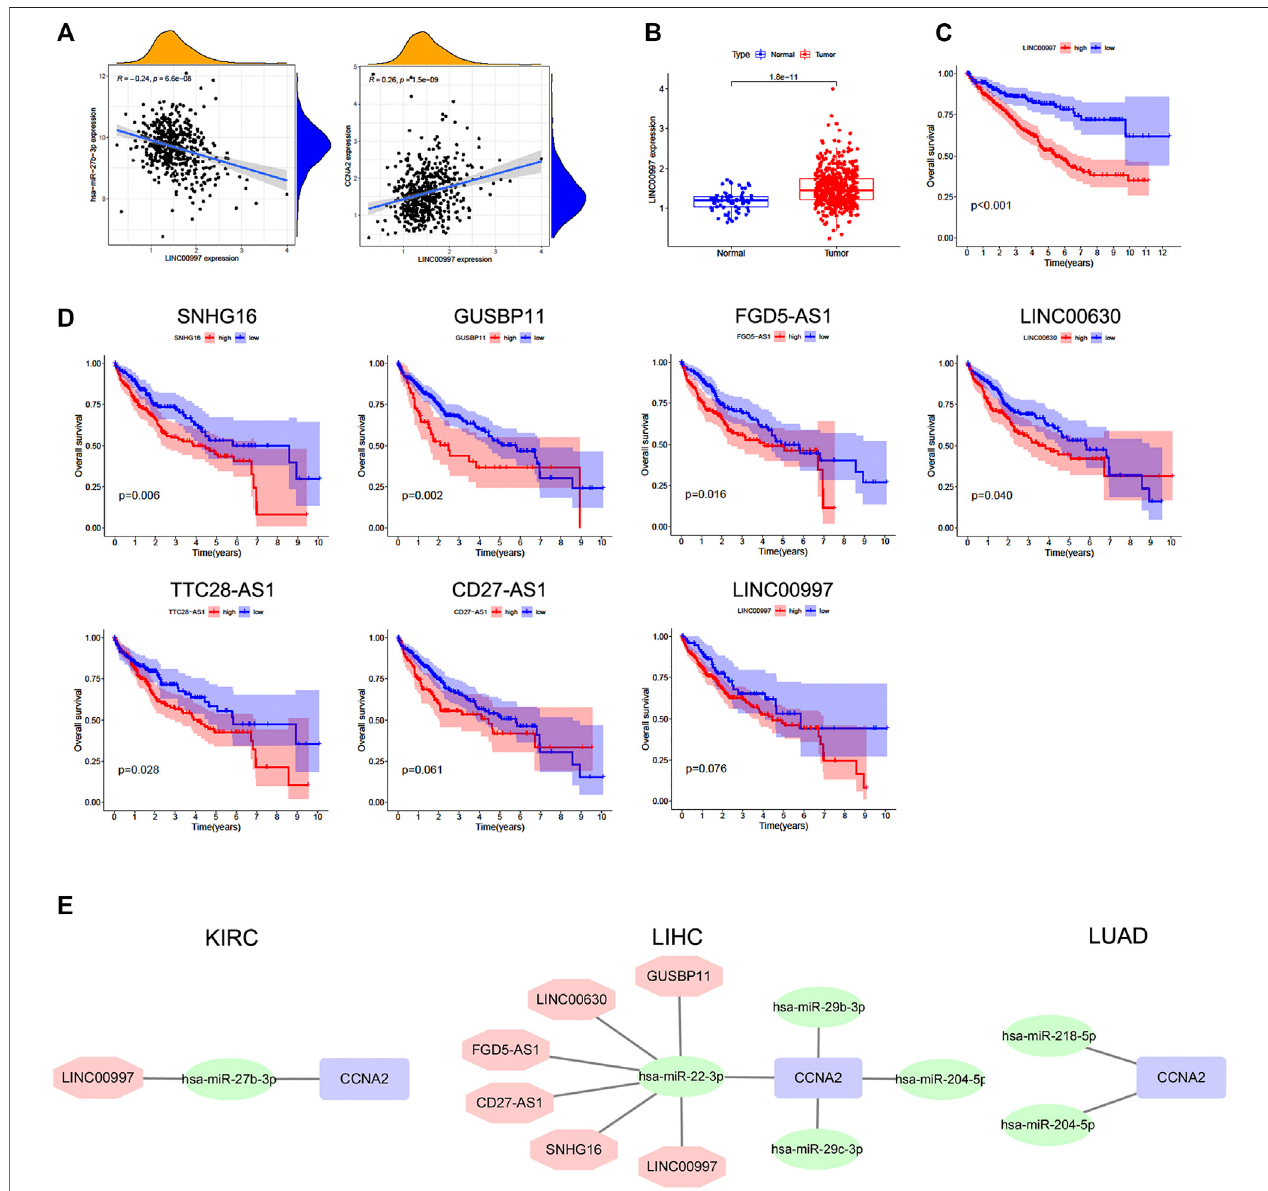
FIGURE 5 | Predictive analysis of upstream lncRNAs of CCNA2-bound miRNAs. The lncRNA expression was shown as log2 (miRNA+1). (A) Correlation of LINC00997expressionwithmiR-27b-3p(left)andCCNA2(right)inKIRC,num=545. (B) TheexpressionofLINC00997inKIRCandnormaltissues,(num(T)=545;num (N) = 71). (C) Overall survival analysis based on the LINC00997 expression in KIRC, num = 545. (D) Overall survival analysis based on miR-22-3p-bound lncRNAs (SNHG16, GUSBP11, FGD5-AS1, TLINC00630, TTC28-AS1, CD27-AS1, and LINC00997) expression in LIHC, num = 375. (E) Predictive upstream regulatory networks of CCNA2 in KIRC, LIHC, and